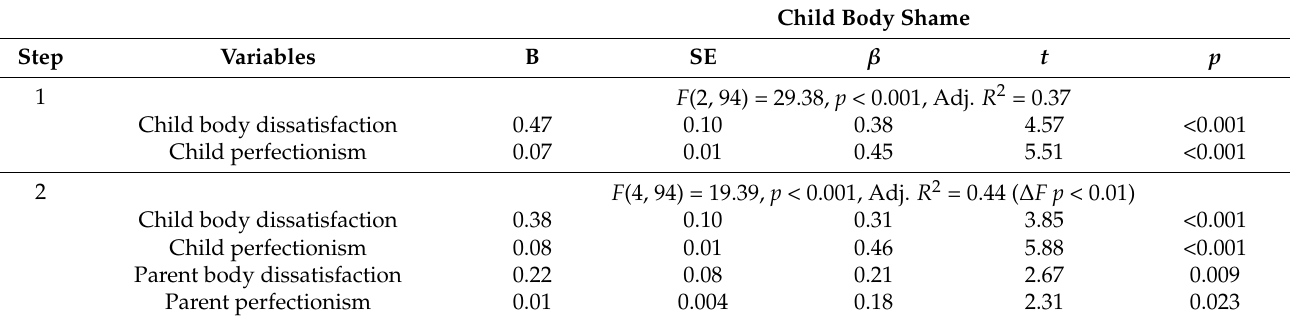
Table 5. Results of hierarchical regression analysis for the prediction of child body shame in